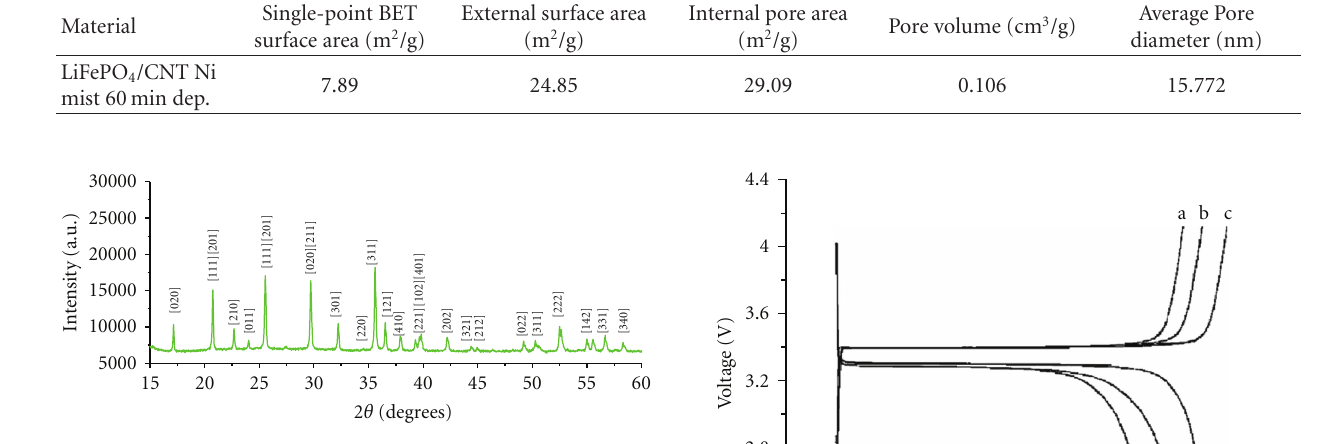
Figure 3: XRD patterns of LiFePO 4 /CNT composite cathode material. The surface area and porosity results obtained for the composite cathode materials are tabulated in Table 2.